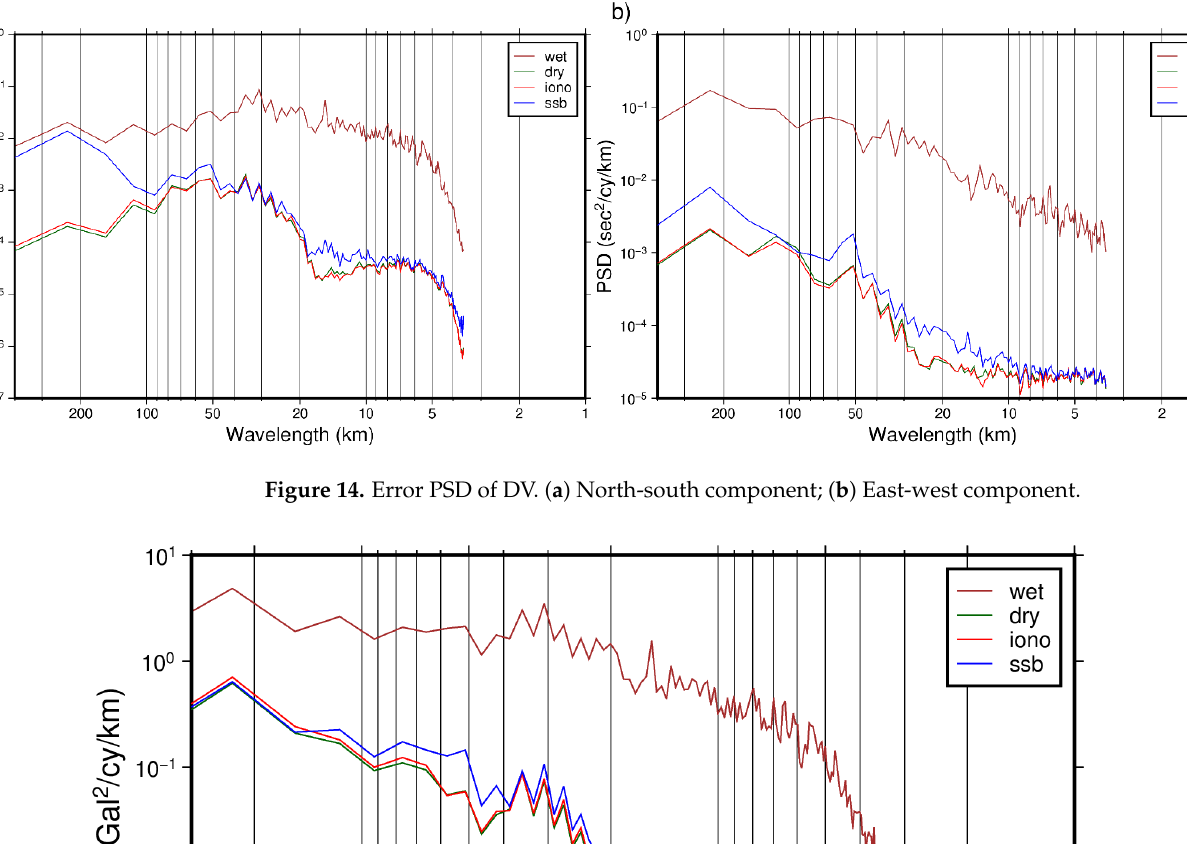
Figure 13. Error PSD of SSH. ( a ) absolute height; ( b ) relative height.